Question: According to the figure, is the described quantity increasing or decreasing?
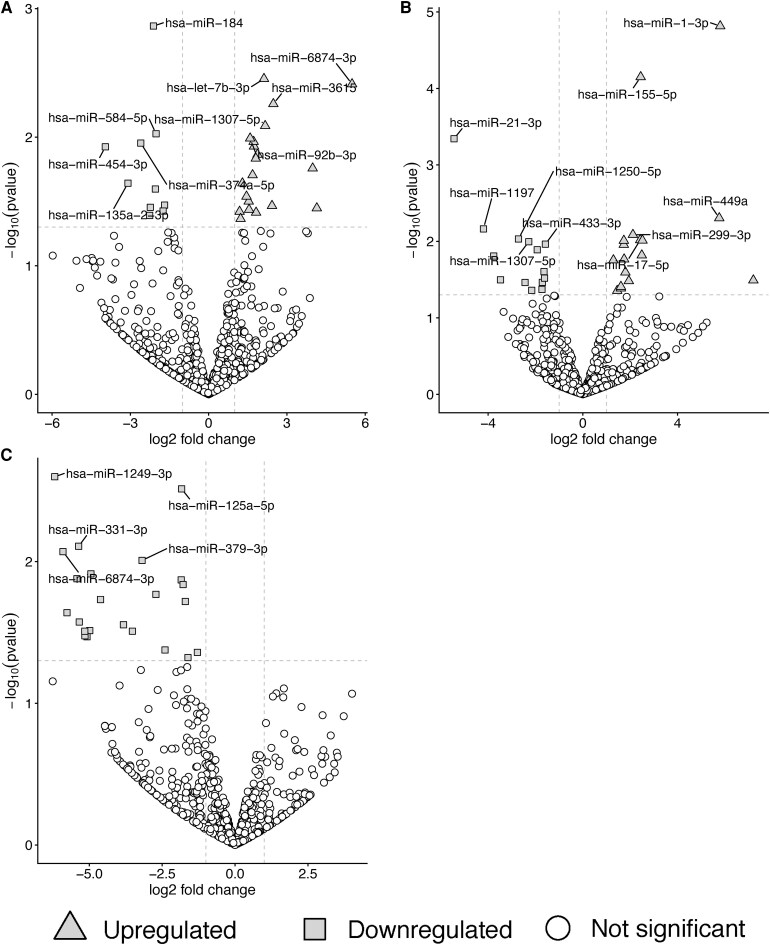
Answer: increasing